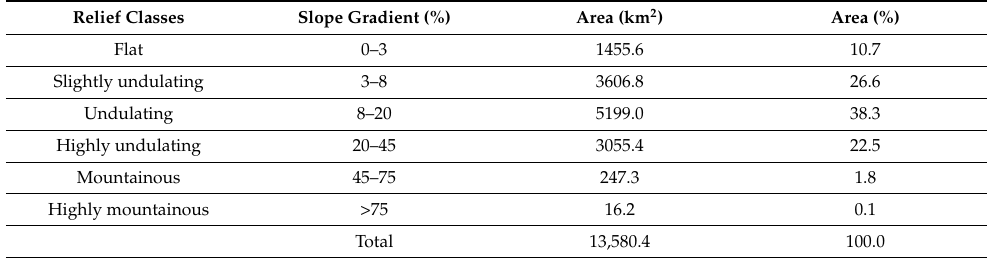
Table 1. Relief classes and percentages of slope in the Paraopeba River Basin [42]. Relief